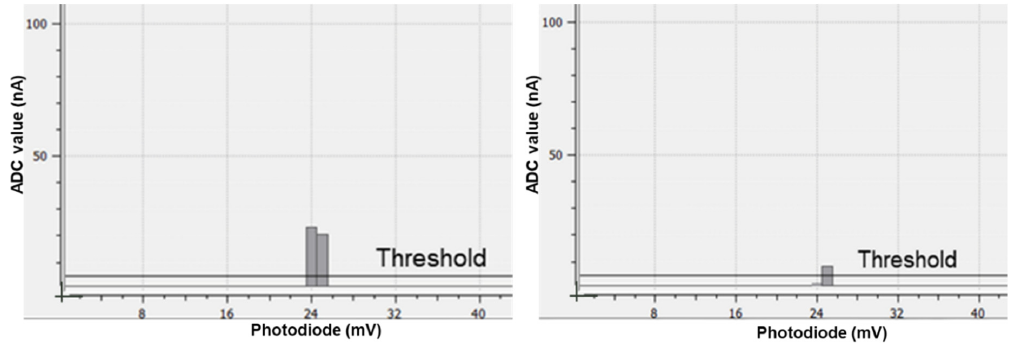
Figure 17. Calibrated temperature measurement using embedded FBG sensor on INC 718 speci- men A523-7 (test cycle#2). (Note: loss of data caused by impaired signal strength, which in turn shows that the FBGs start to erase).